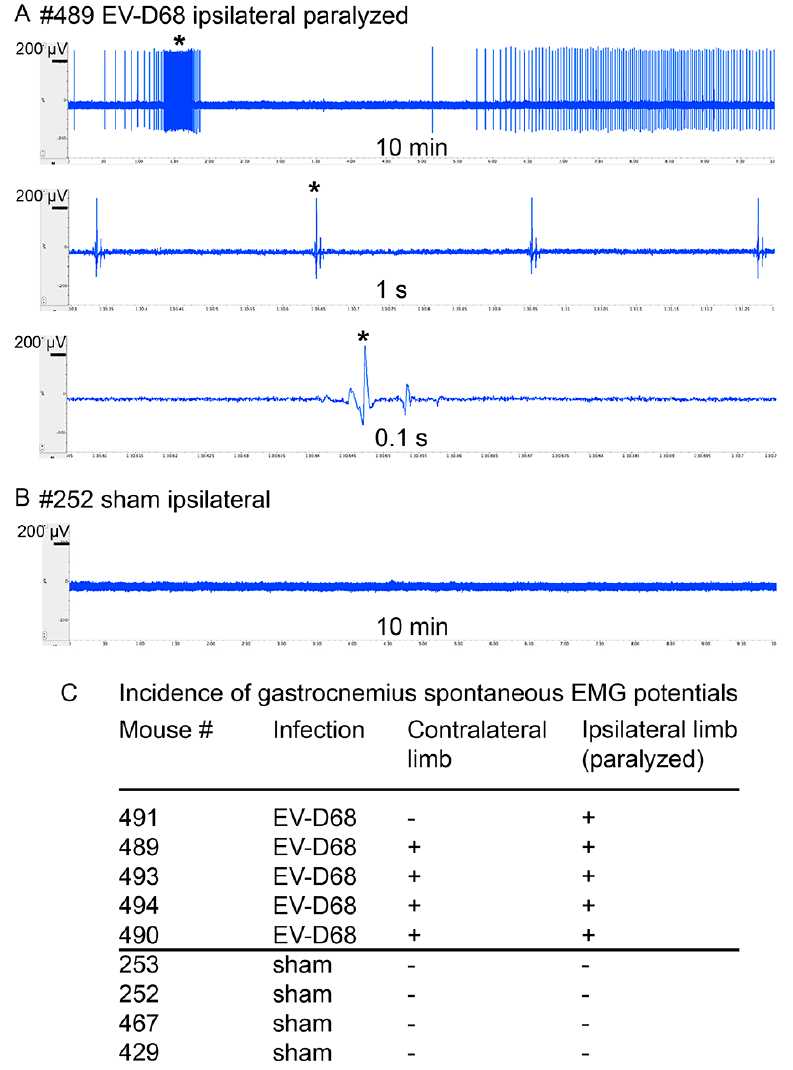
Figure 4. F-wave tracings and latency stimulated at popliteal nerve behind knee and recorded at plantar muscles from AG129 mice infected with EV-D68 six weeks after onset of paralysis. ( A ) F-wave of contralateral hindlimb of #252 sham mouse; ( B ) F-wave of contralateral hindlimb of #491 EV-D68- infected mouse; ( C ) F-wave latencies among EV-D68-infected and sham-infected mice.